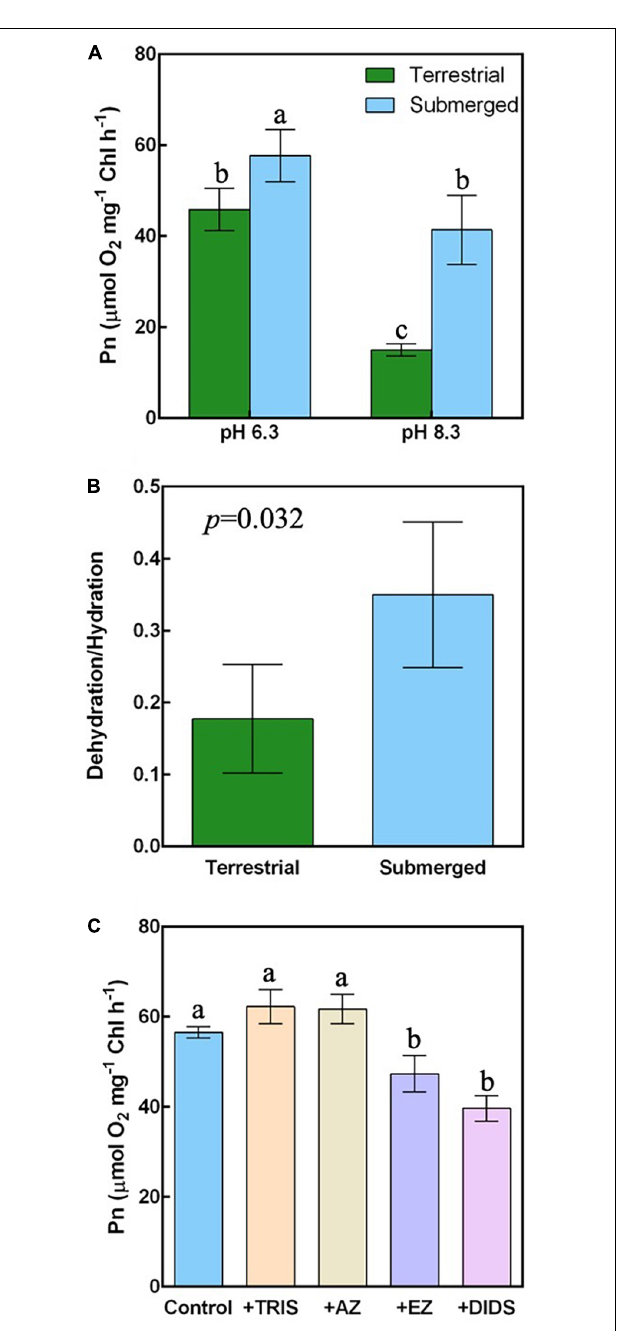
FIGURE 2 | Photosynthetic HCO 3 − utilization in the terrestrial and submerged leaves of H. polysperma . (A) Underwater photosynthetic rate (Pn) under different DIC conditions ( n = 3). The DIC constituents (CO 2 and HCO 3 − ) in the medium at pH 6.3 were present at a ratio of 1:1 and HCO 3 − only at pH 8.3, respectively. The medium contained 10 mM NaHCO 3 , 1.5 mM KCl, and 1.0 mM NaCl. (B) The ratio of HCO 3 − dehydration to CO 2 hydration reactions of CA ( n = 4). (C) Influence of HCO 3 − inhibitors on underwater Pn of the submerged leaves ( n = 3). Underwater Pn was measured under HCO 3 − conditions (pH 8.3) in the presence of 0.1 mM AZ, 0.1 mM EZ, 50 mM TRIS, or 0.3 mM DIDS. (A,C) Data were analyzed with Tukey’s HSD test. Different letters indicate statistical differences between the treatments ( p < 0.05). (B) Data were analyzed with Student’s t